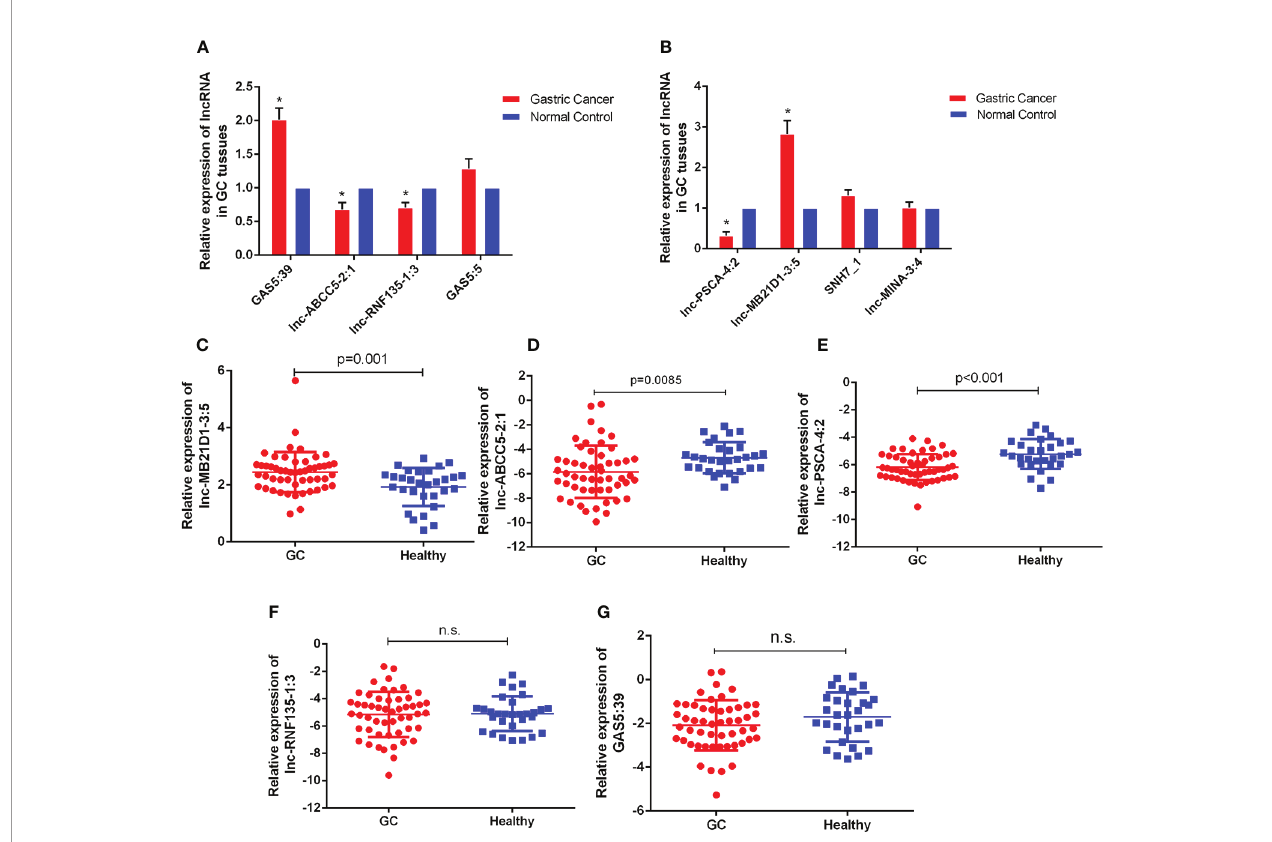
FIGURE 4 | The expressions of lncRNAs GC tissues and bloods. (A, B) Expression of eight lncRNAs in GC tissues compared to normal controls. The correlation of their - D Ct value was determined. *P < 0.05 (C – G) Expression of fi ve lncRNAs in GC bloods compared to healthy controls. n.s., no signi fi